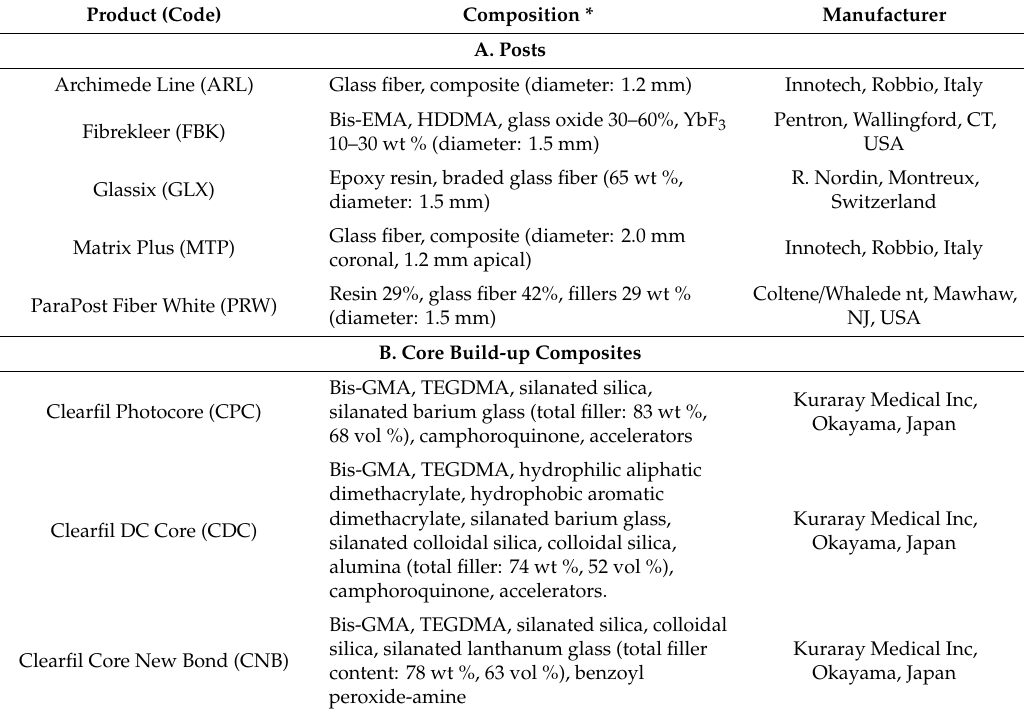
Table 1. The materials used in the study.